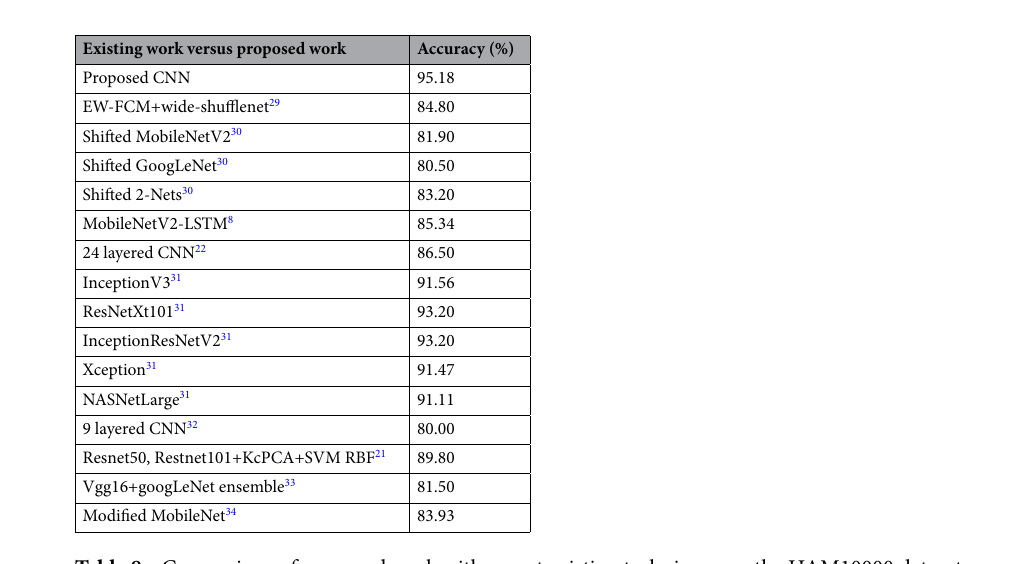
Table 8. Comparison of proposed work with recent existing techniques on the HAM10000